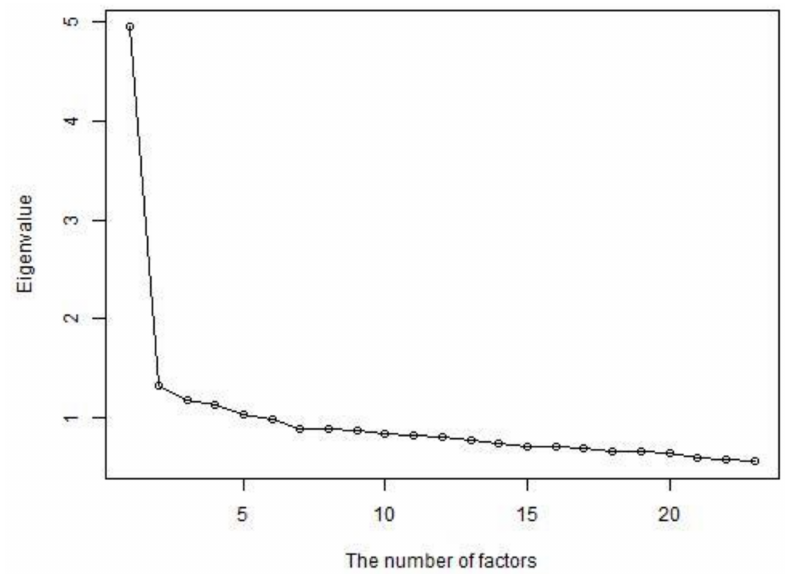
Figure 1. Scree plot of the 29 items of the COVID-19-related difficulties (CORDI) item set.